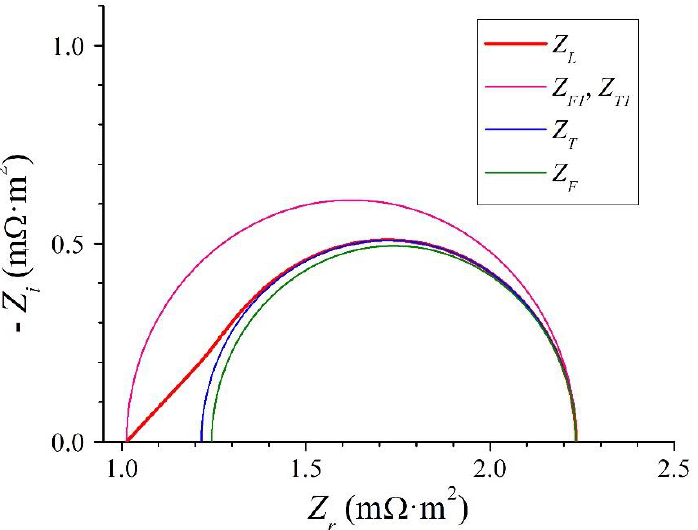
Figure 5. Nyquist plots of the impedance of ion-exchange membrane systems at low frequencies for I DC = 0 and the approximated impedances obtained according to developments of the Warburg impedance.